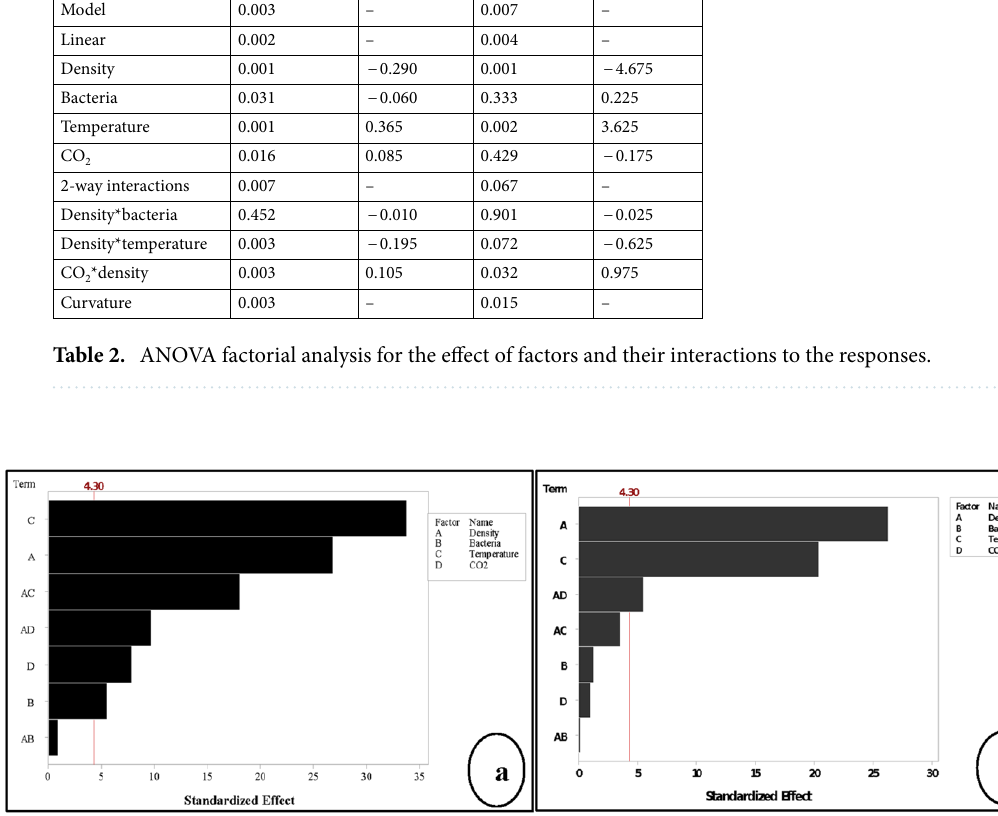
Figure 6. Pareto chart of the standardised effects by the factorial analysis α = 0.05 ( a ) response is initial water absorption ( b ) response is water